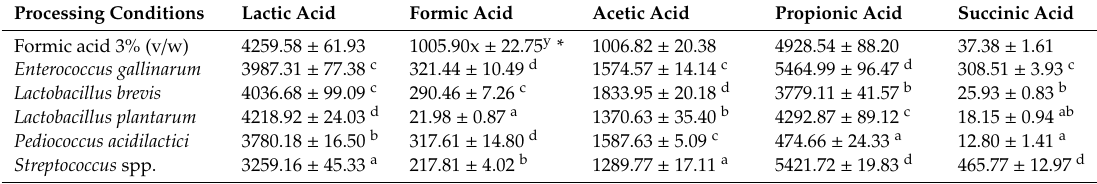
Table 9. Yield (mean values ± standard deviation, expressed in mg organic acid / 100 g sample ) ( n = 3) of organic acids in acidified and fermented spray-dried fish processing by-product silages of 3 weeks. In the fish silages, the acidic conditions were obtained by adding formic acid 3% (v / w), whereas the fermentation were carried out by independent inoculations with pure cultures of distinct lactic acid bacteria